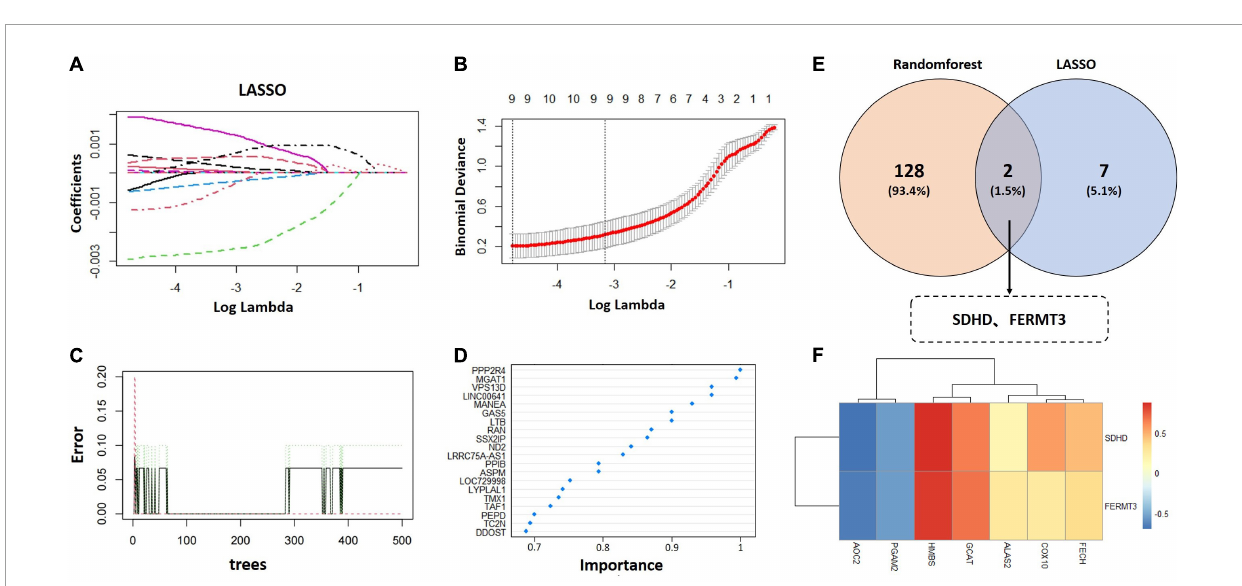
FIGURE5 Selection of signature genes. (A) Parameter selection was performed through LASSO regression. (B) Elucidation of LASSO coefficient profiles for selected factors. (C) Random forest error rate versus the number of classification trees. (D) The top 20 relatively important genes. (E) Venn diagram to identify signature genes between LASSO and random forest. (F) Heatmap of correlation analysis between two signature genes and metabolism related genes (ALAS2, FECH, COX10, GCAT, HMBS, PGAM2, and AOC2). LASSO, the least absolute shrinkage and selection